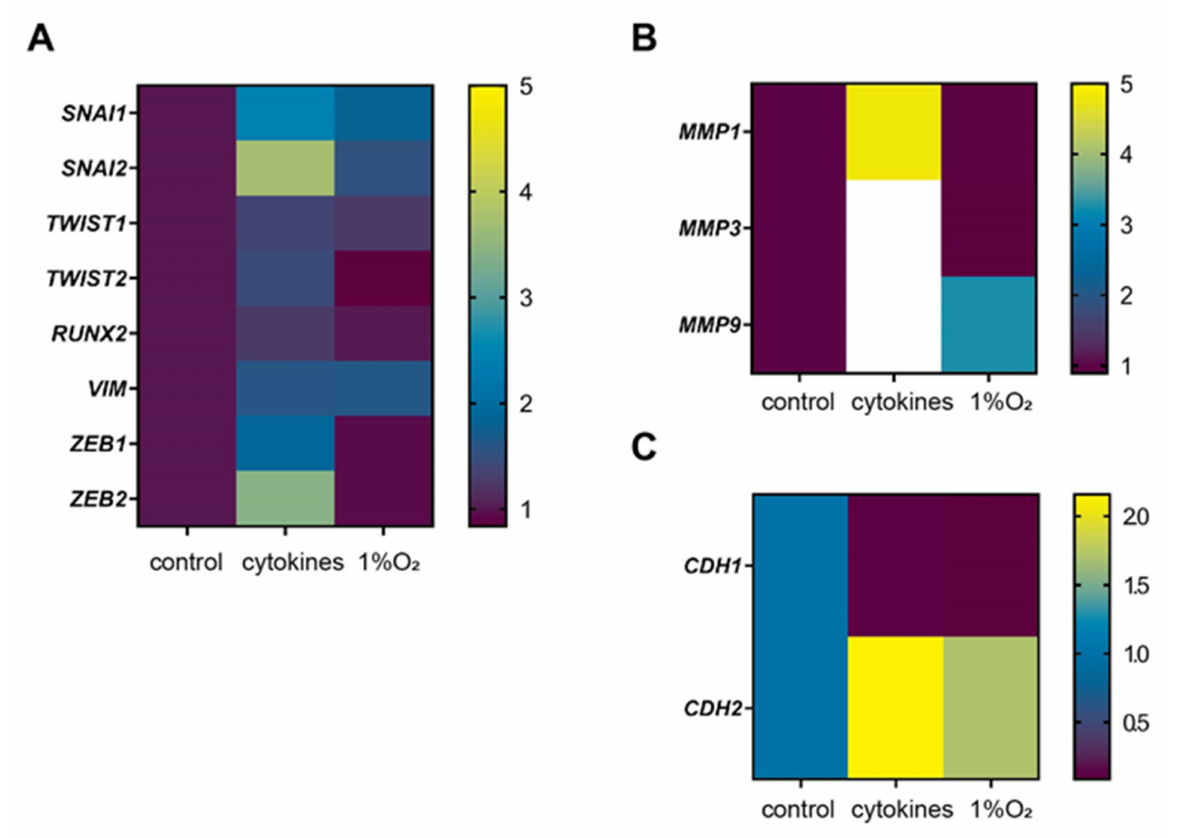
Figure 5. Representative genes of EMT induced by cytokines. Genes for transcription factors associated with ( A ) EMT, ( B ) MMP, ( C ) and cadherin, identified using the TRRUST